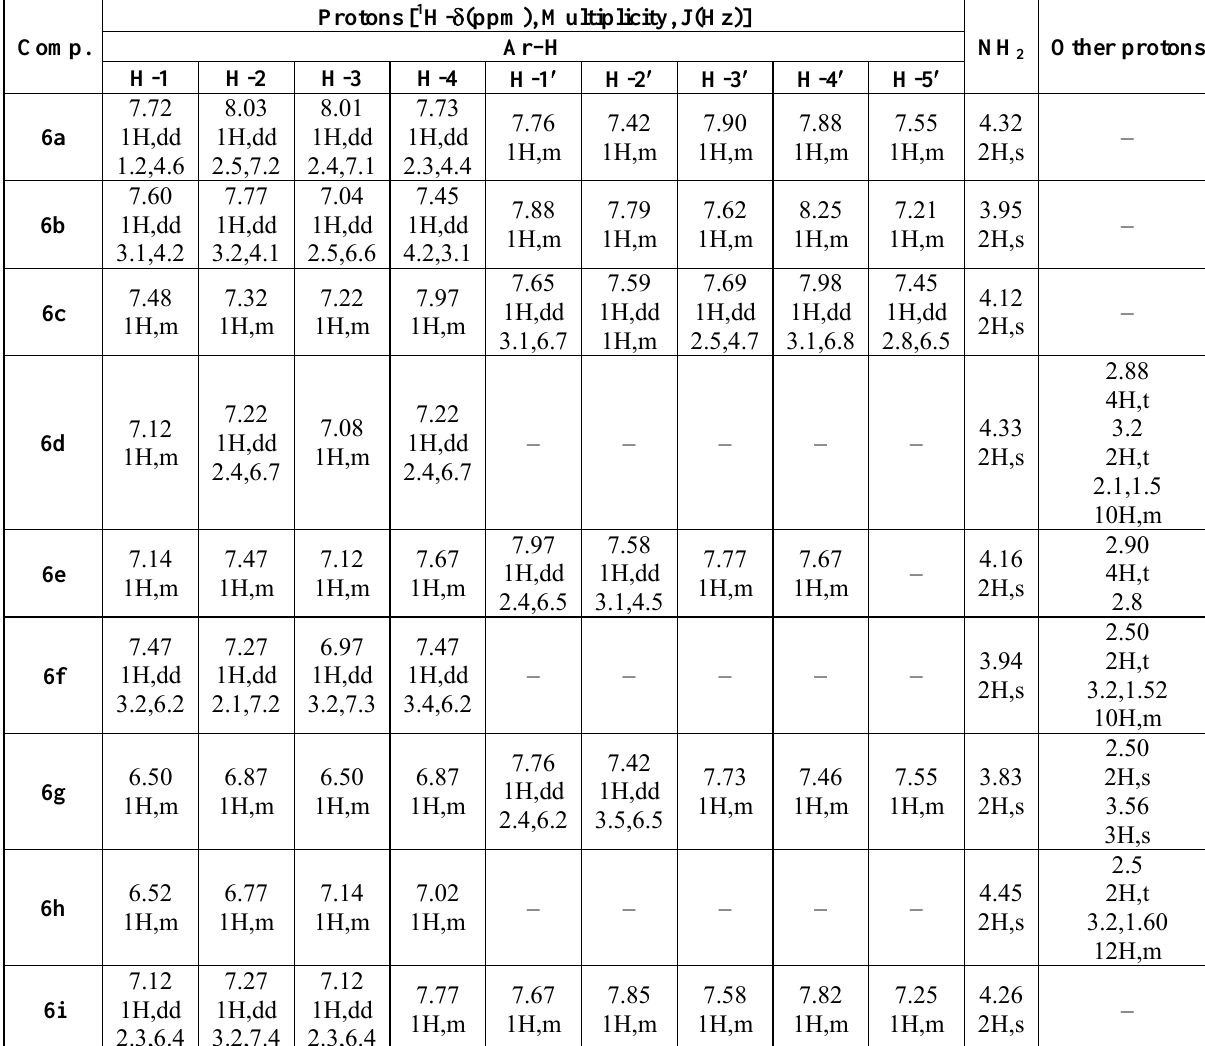
Table 1. 1 H-NMR spectral data of 5-substitued-4-amino-1,2,4-triazole-3-thioesters 6a-i .